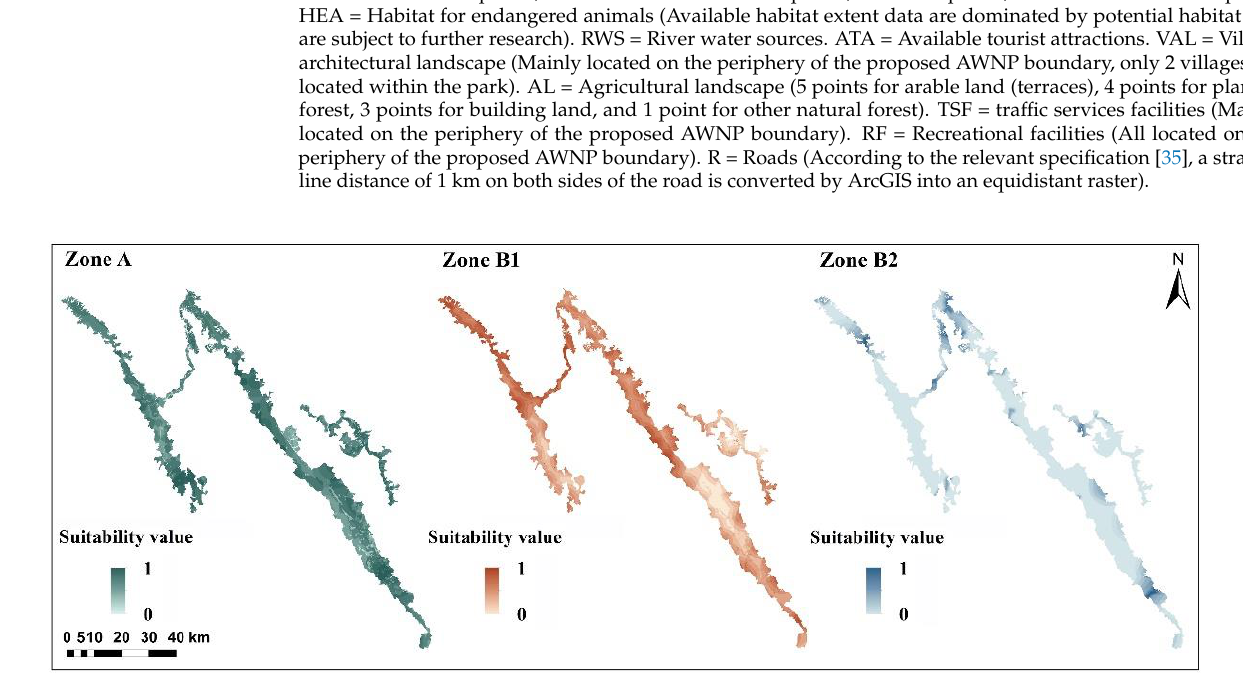
Figure 4. Land suitability maps for Zones A, B1, and B2.